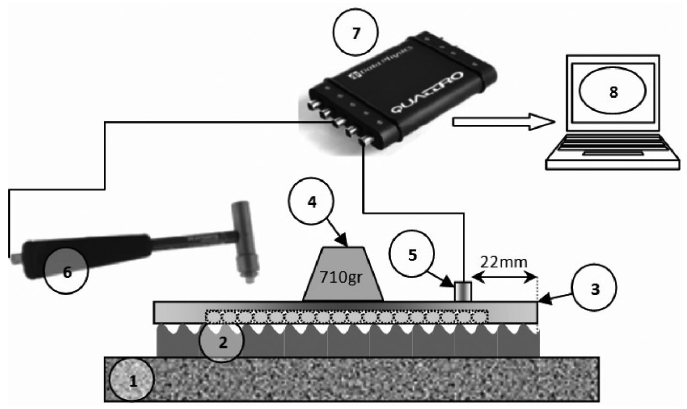
Fig. 63. Experimental rig